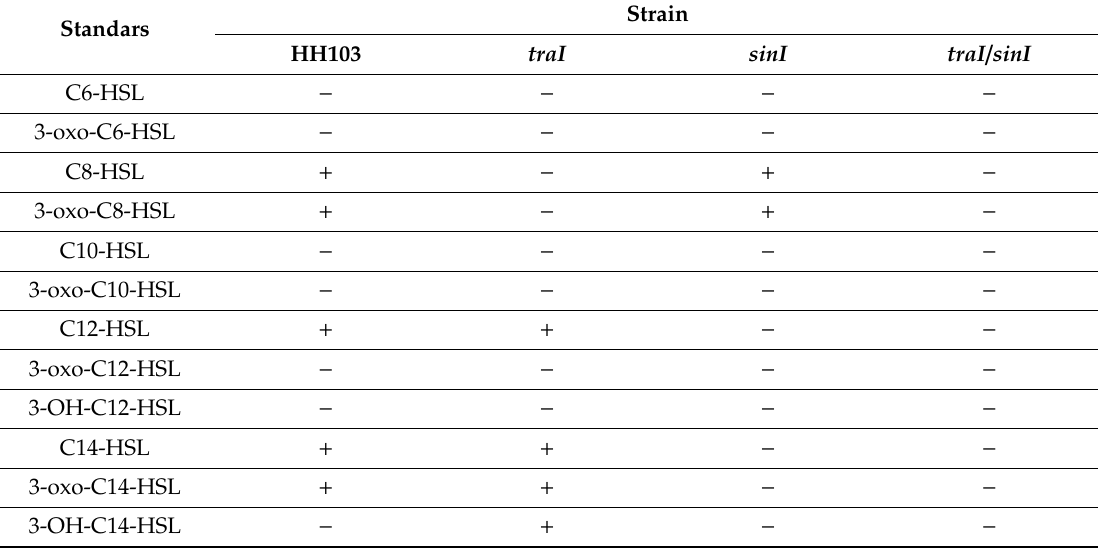
Figure 1. thin layer chromatography (TLC) analysis of N-acyl-homoserine lactones (AHLs) produced (100-fold) by S. fredii HH103 strains at four different OD600 (0.3, 0.6, 0.9 and 1.2) in YM medium. Migration of two different AHL standards (C8-HSL and C14-HSL) is shown on the left of each panel. Table 3. AHLs identified by HPLC-MS/MS in supernatants of S. fredii strains (+: detected, − : not detected).